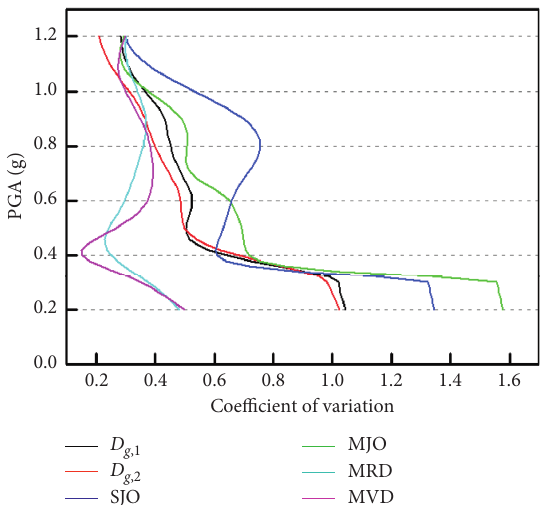
Figure 18: Dispersion curves at different earthquake